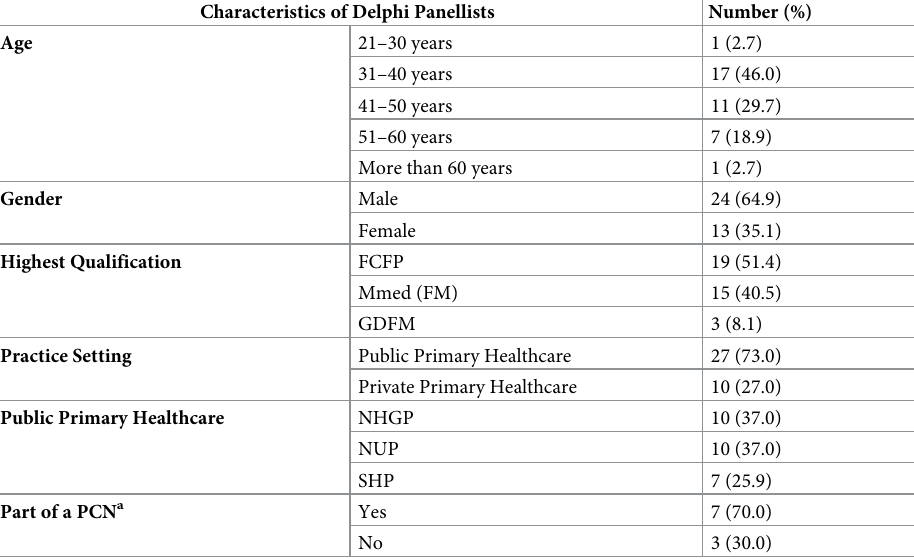
Table 1. Baseline descriptive characteristics of Delphi